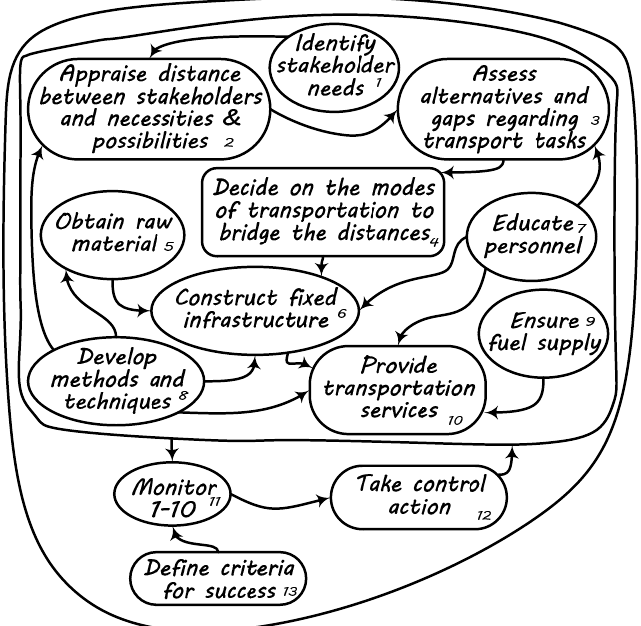
Figure 5. Conceptual activity model (originated by the